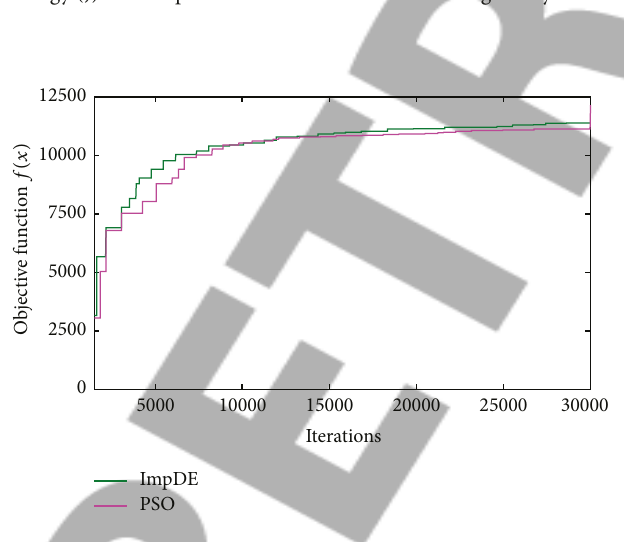
Figure 4: Objective function and its convergence characteristics for energy (J) consumption for 300 sensor nodes and 40 gateways.